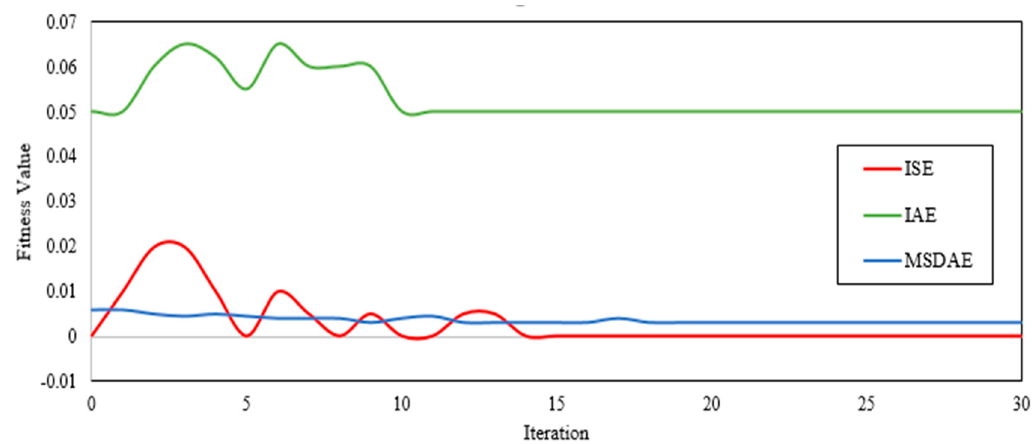
Figure 3. Fitness functions vs. iteration number for linear contour.